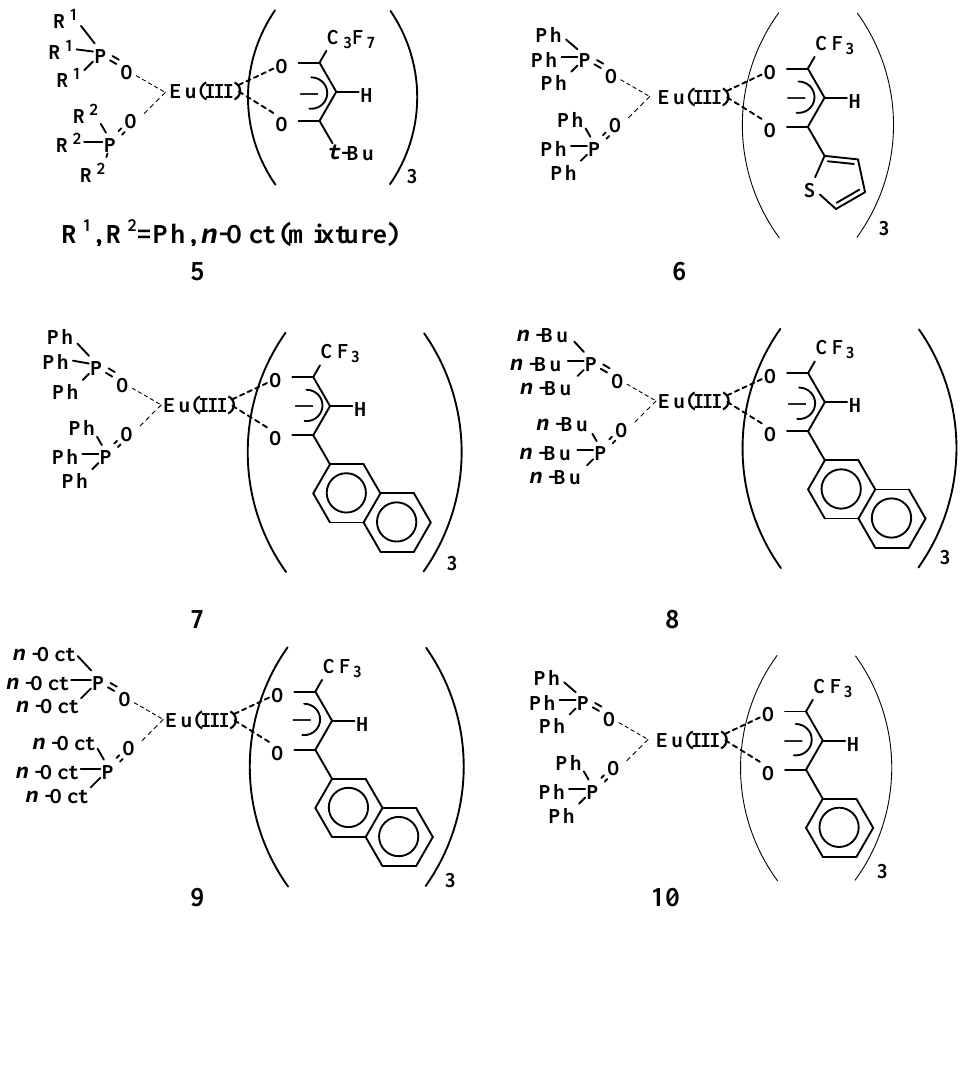
Figure 8. Eu(III) complexes with  -diketonates and phosphine oxides used in this